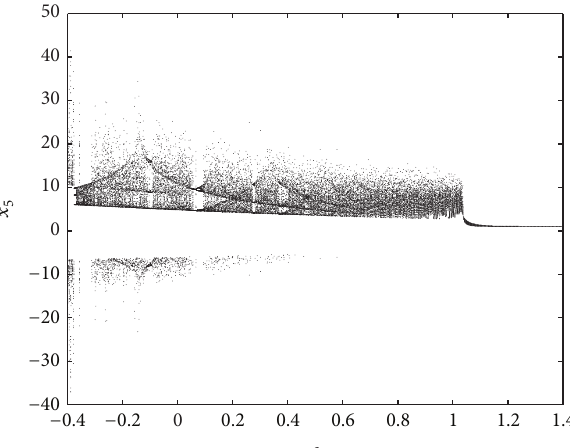
Figure 5: The bifurcation diagram of the system (18) with parameter 𝑐 ∈ [−0.4, 1.4] .